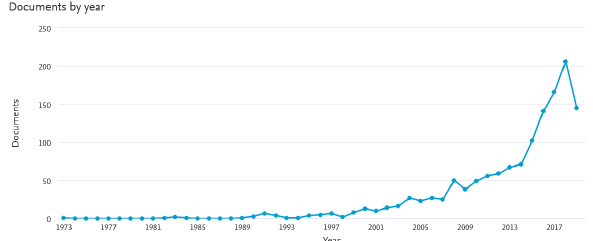
Figure 1. Number of results for query: TITLE-ABS- KEY ("benchmark*" AND ("photogrammetry" OR "remote sensing") ) in Scopus database.